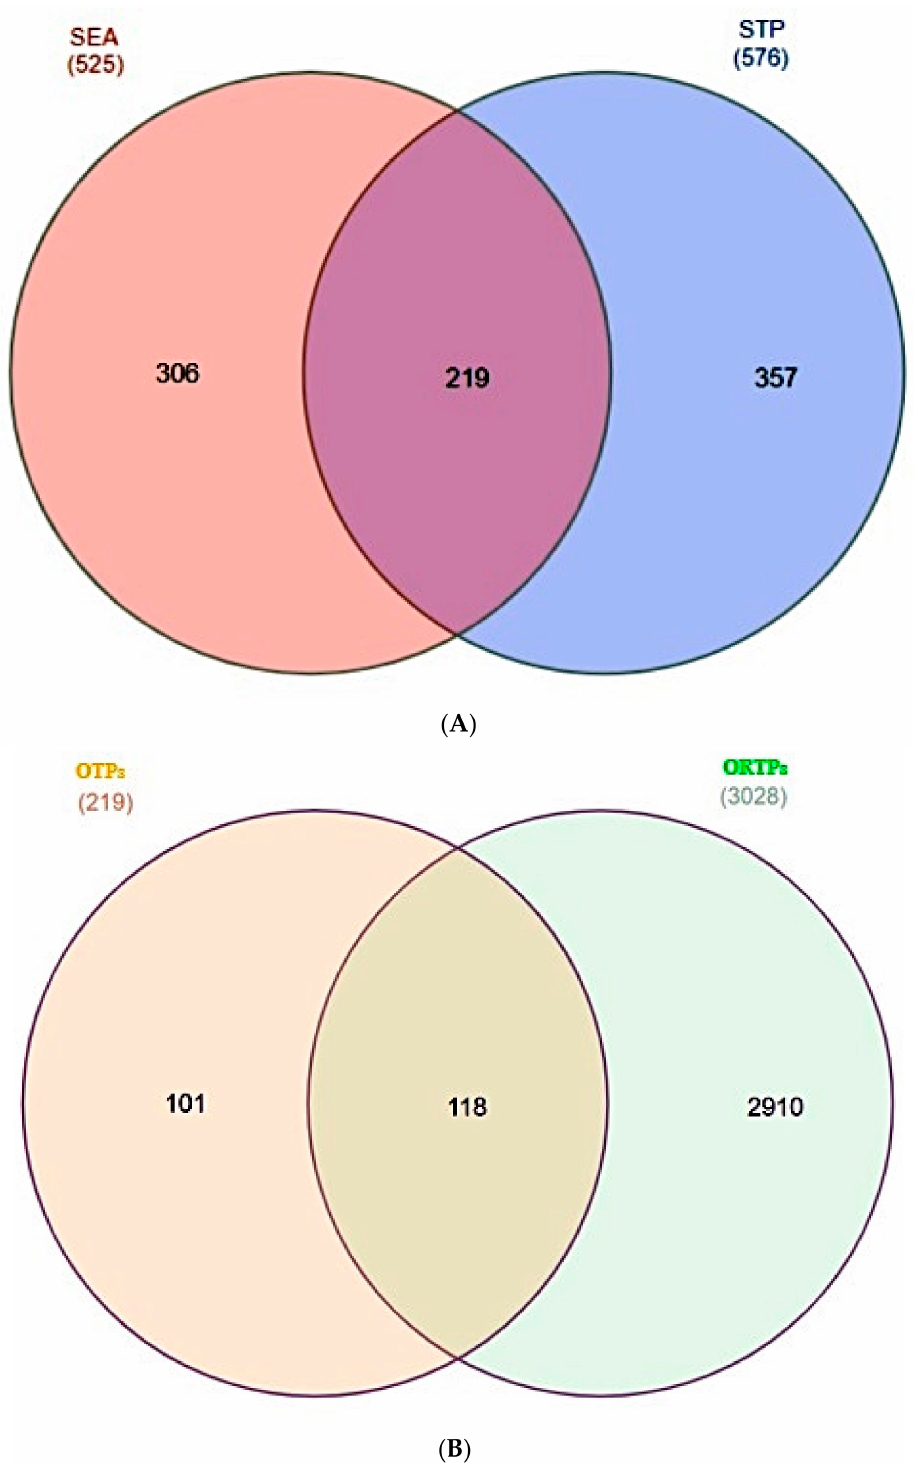
Figure 3. ( A ) The overlapping targets (219) between SEA and STP databases. ( B ) The final targets (118) between the overlapping target proteins (OTPs) (219) and obesity-related target proteins (ORTPs)